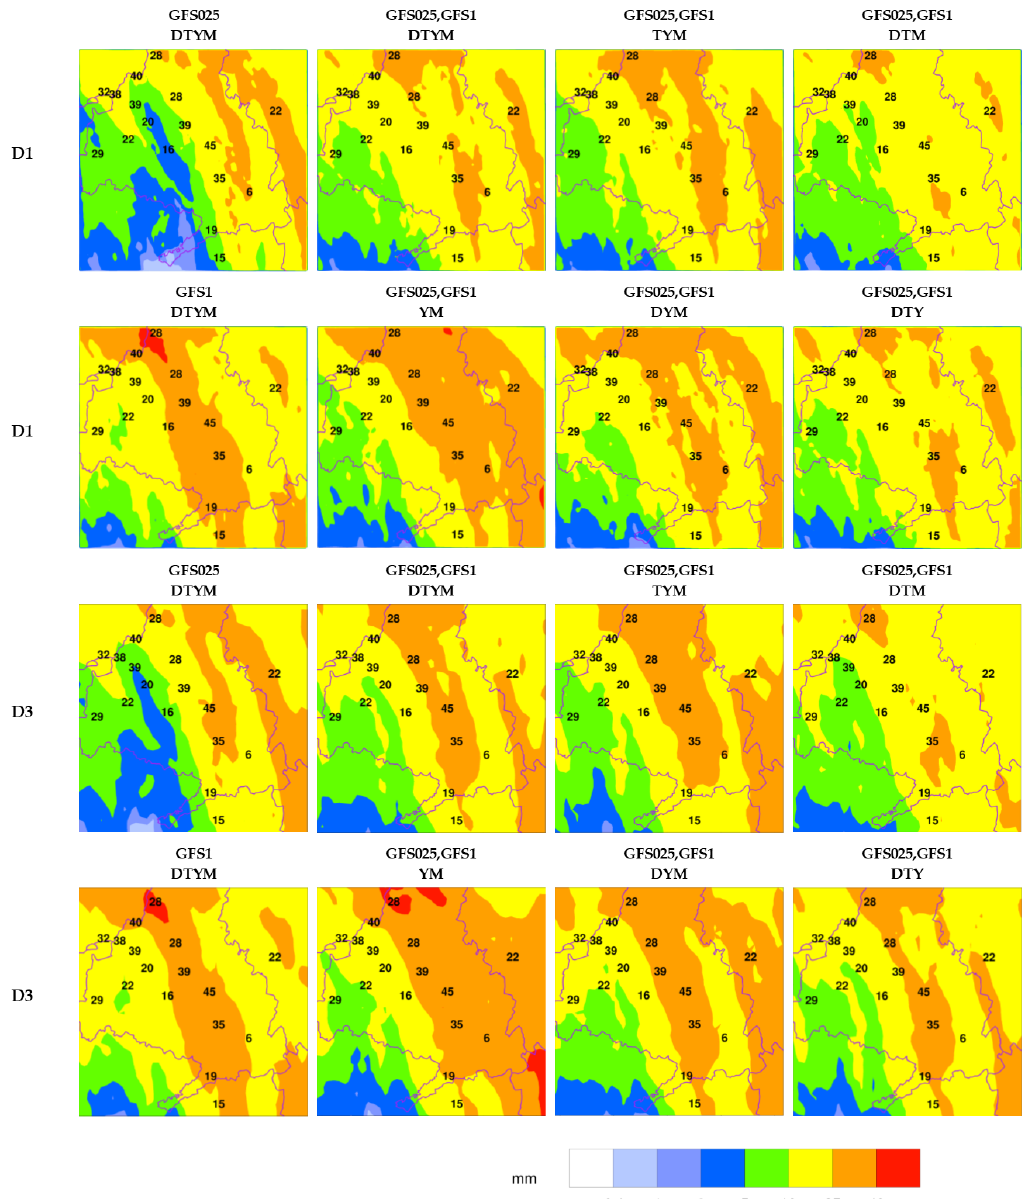
Figure 3. Accumulated precipitation (mm) between 10:00 and 18:00 UTC for ensemble model configurations. Observed accumulated precipitation (mm) for each station is shown at station locations. D3 figures are cropped to match D1.